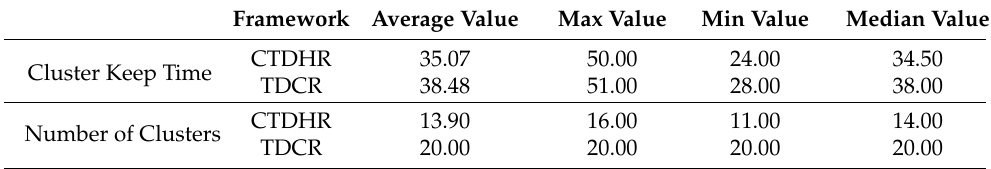
Table 4. Statistics on the stability of clusters and the number of clusters for CTDHR and